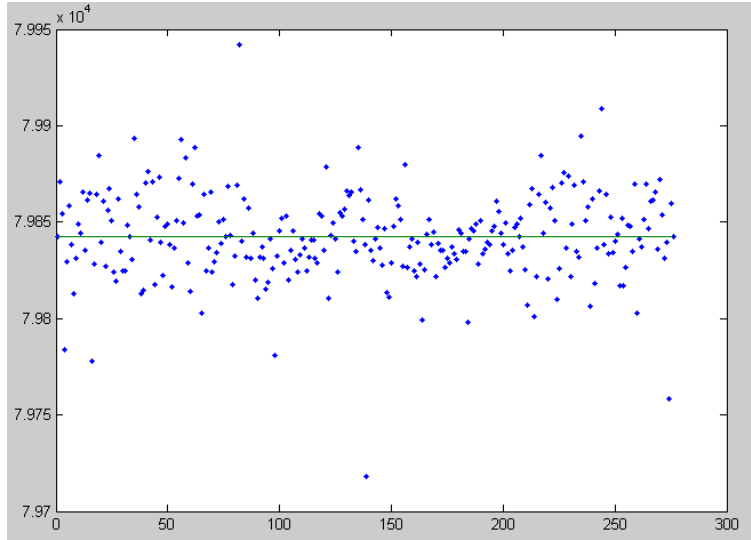
Figure 3. Focal distances computed from all star pairs, and the median value